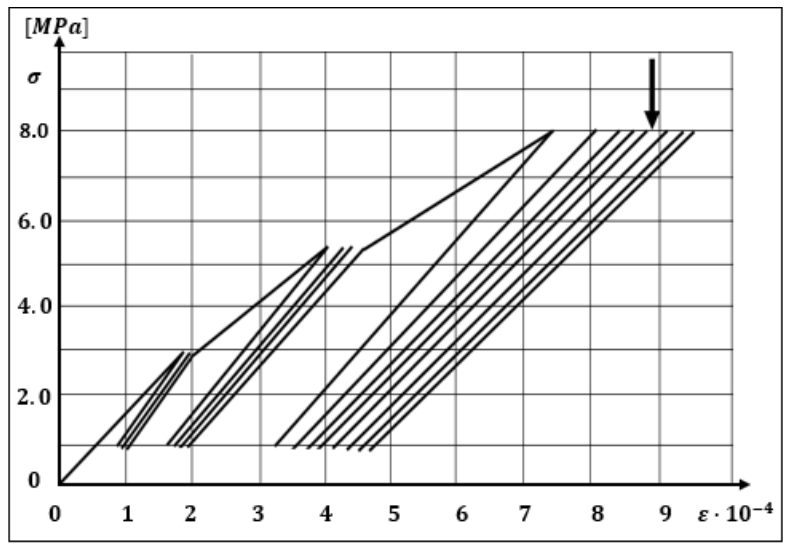
Figure 9. Relation − according to Borcz [21]. Figure 9. Relation σ − ε according to Borcz